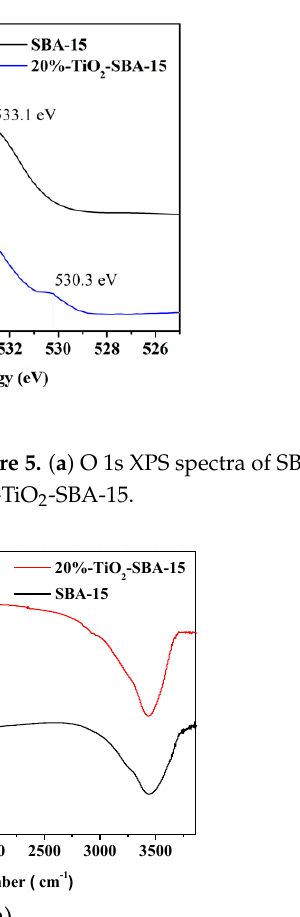
Figure 5. ( a ) O 1s XPS spectra of SBA-15 and 20%-TiO 2 -SBA-15, ( b ) Si 2p XPS spectra of SBA-15 and 20%-TiO 2 -SBA-15.